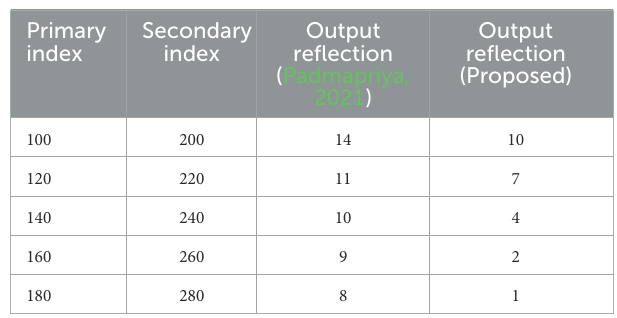
TABLE 3 Reflection at output.